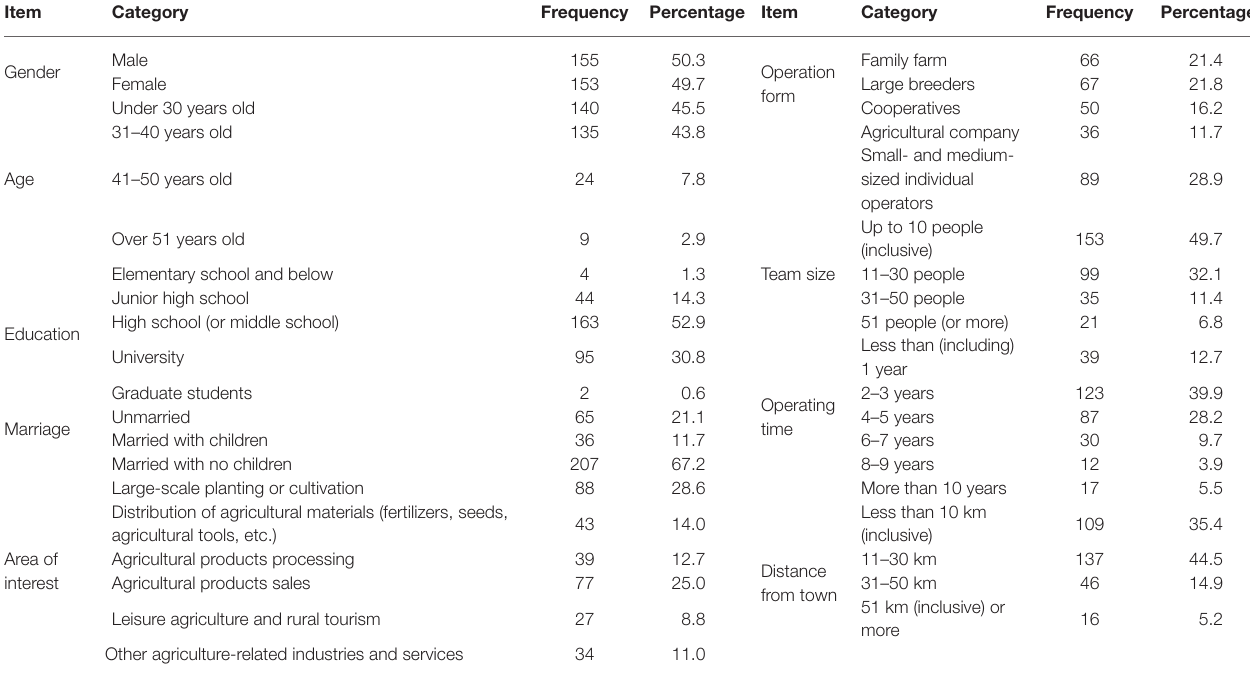
TABLE 1 | Basic description of the official survey